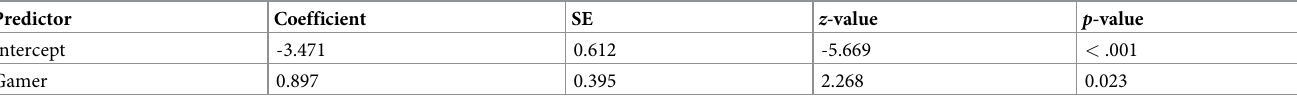
Table 1. Experiment 1: Mixed logit analysis of participant gaming responses. Predictor